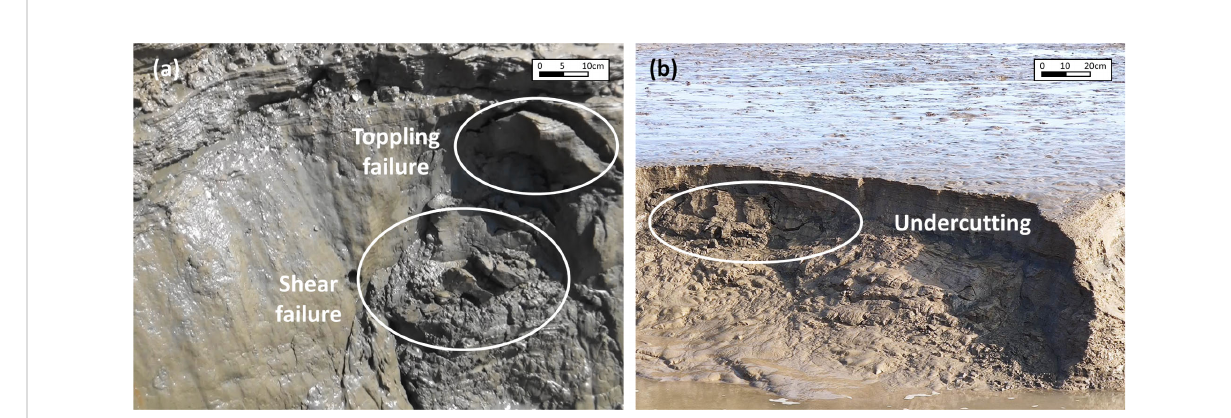
FIGURE 1 Field photograph showing bank retreat process caused by seepage: (A) toppling and shear failure; (B) seepage undercutting. These photos were taken from Jiangsu coast, eastern